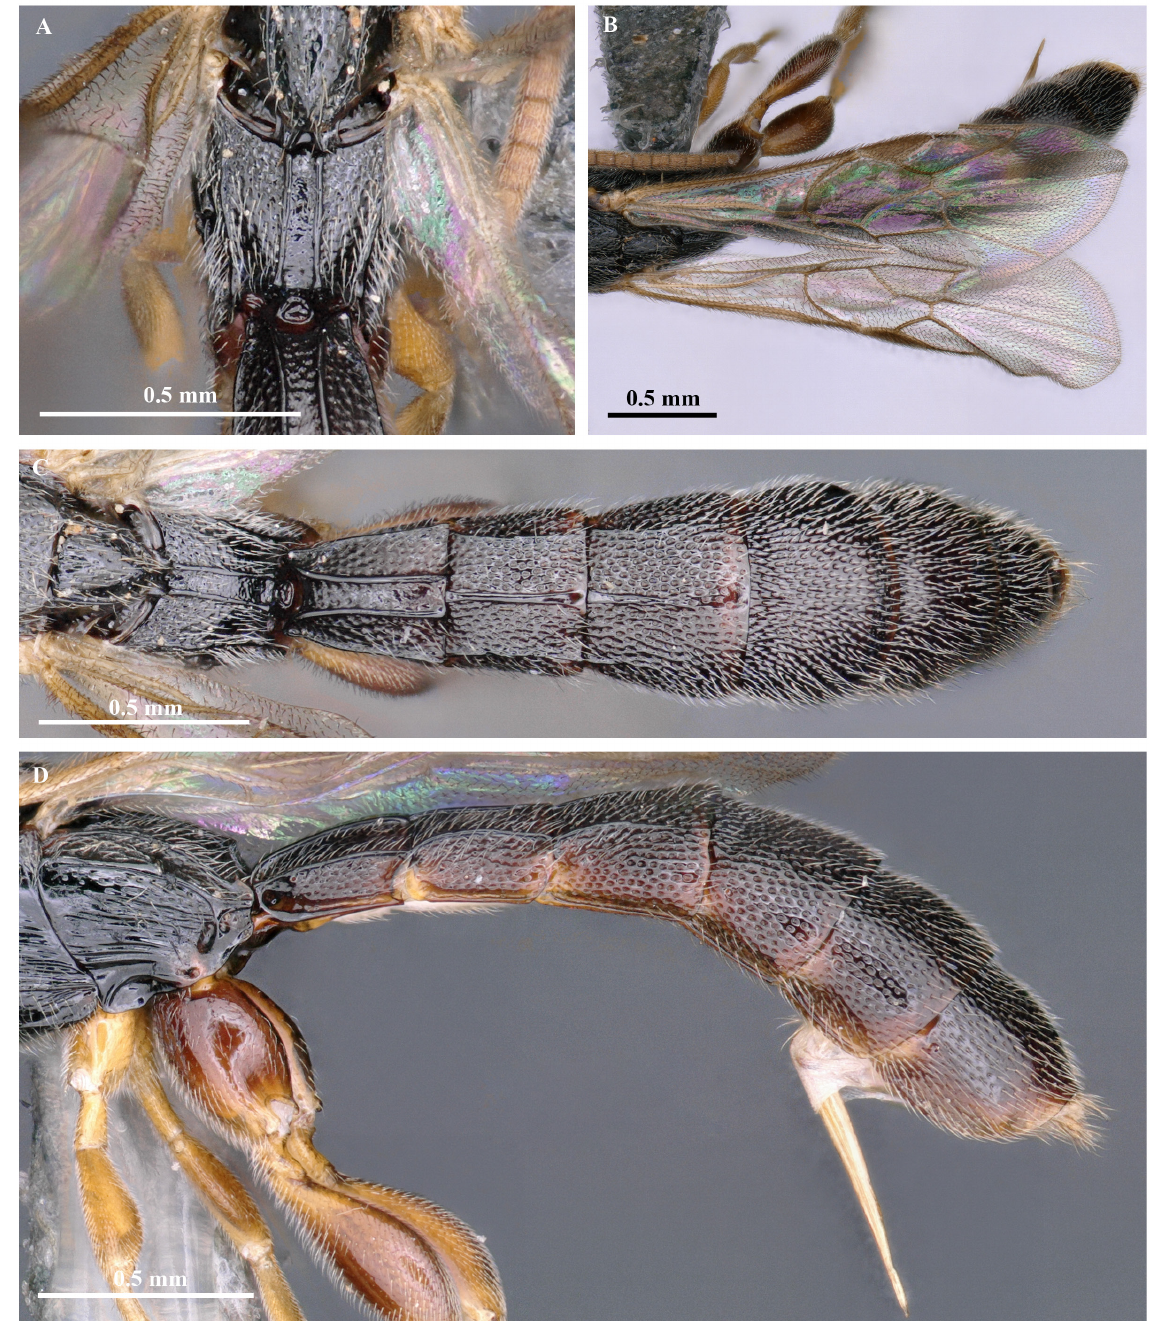
Fig. 4. Trieces isolatus sp. nov., holotype, ♀ (AIMB). A . Propodeum, dorsal view. B . Fore wing. C . Metasoma, dorsal view. D . Metasoma, lateral